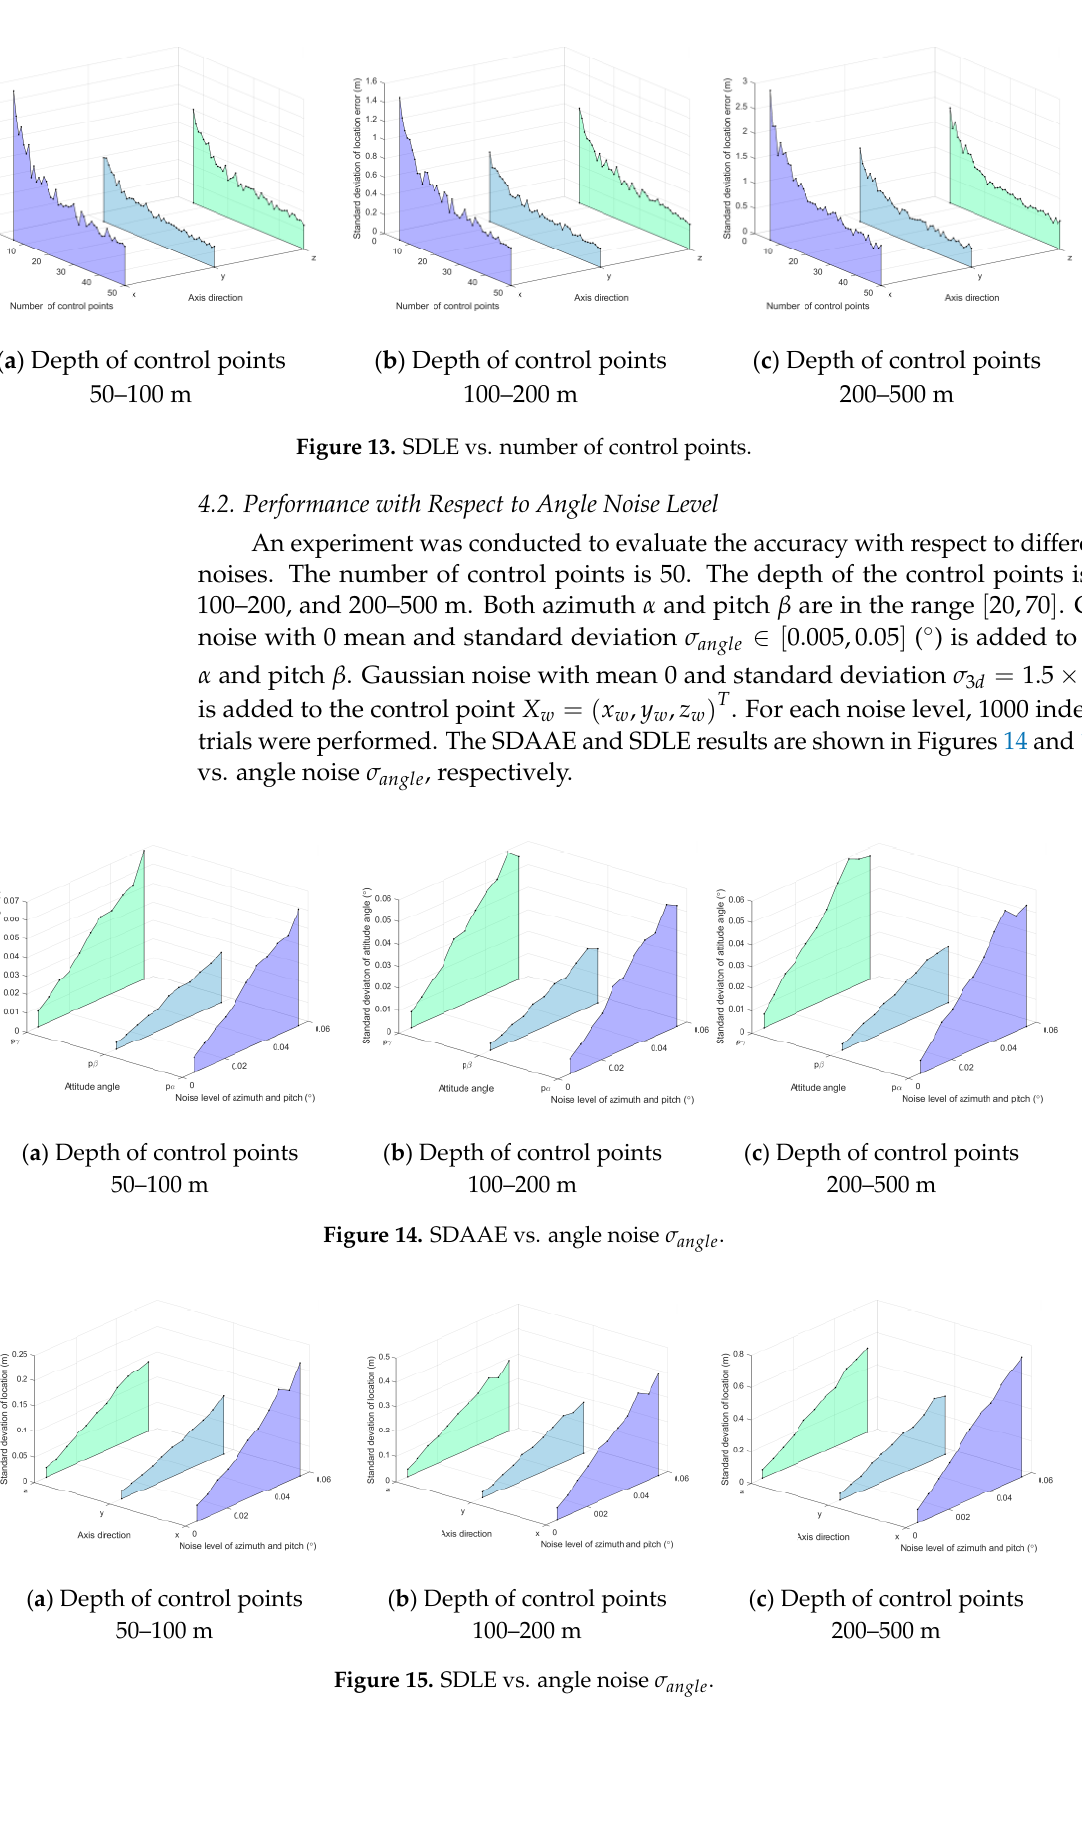
Figure 12. SDAAE vs. number of control points.